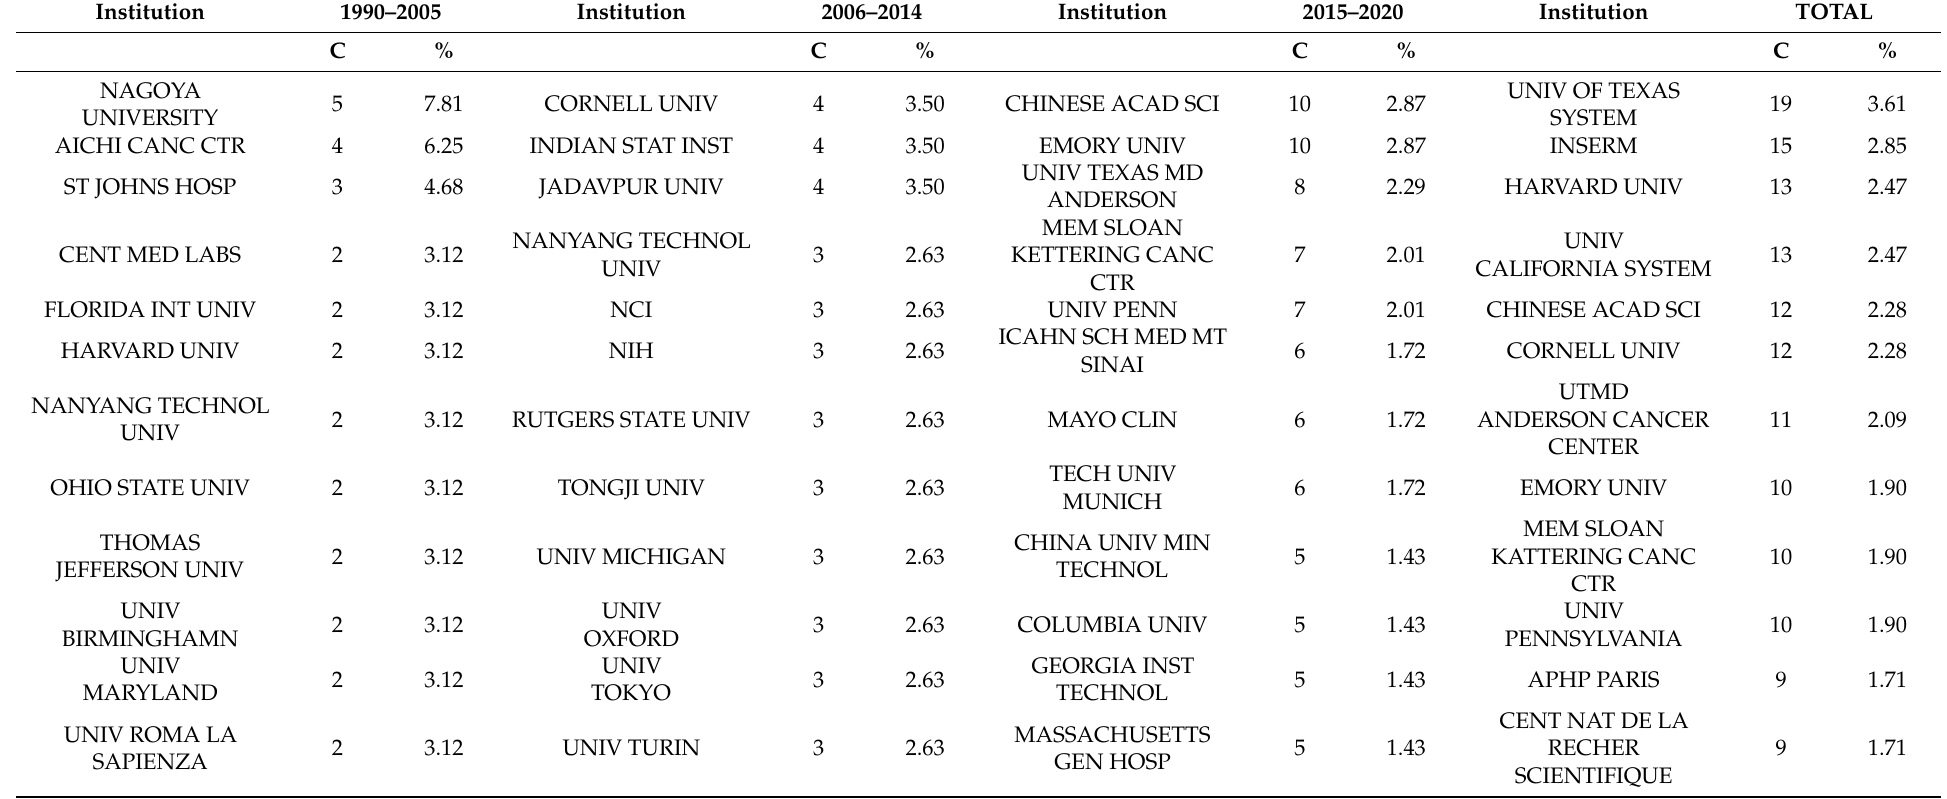
Table 1. Analysis of documents referred to AI and ML applications to diagnostic pathology in lymphoid neoplasms by institutions from 1990 to 2020. Data are provided by